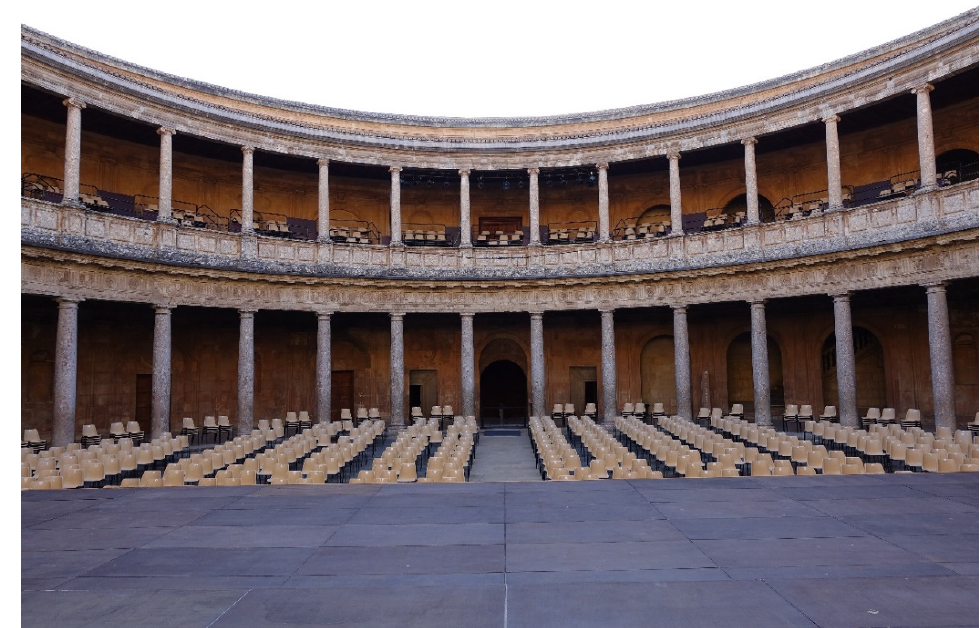
Figure 3. The Palace during the measurement campaign.